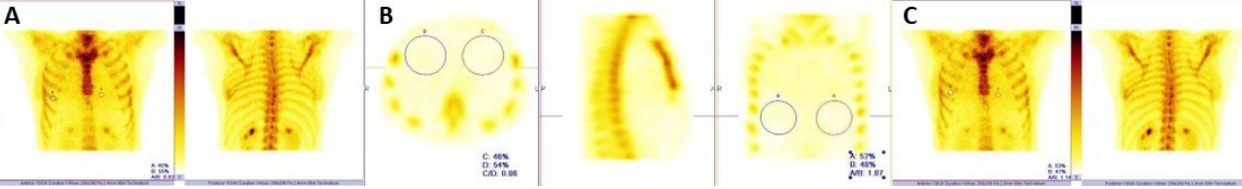
Table 10. Semiquantitative Method for AL positive patients.